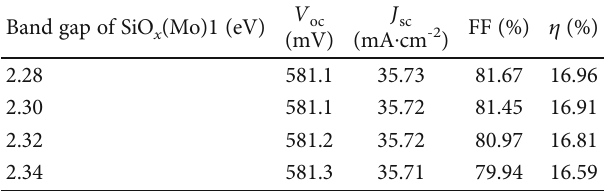
/ n -Si solar cells with x